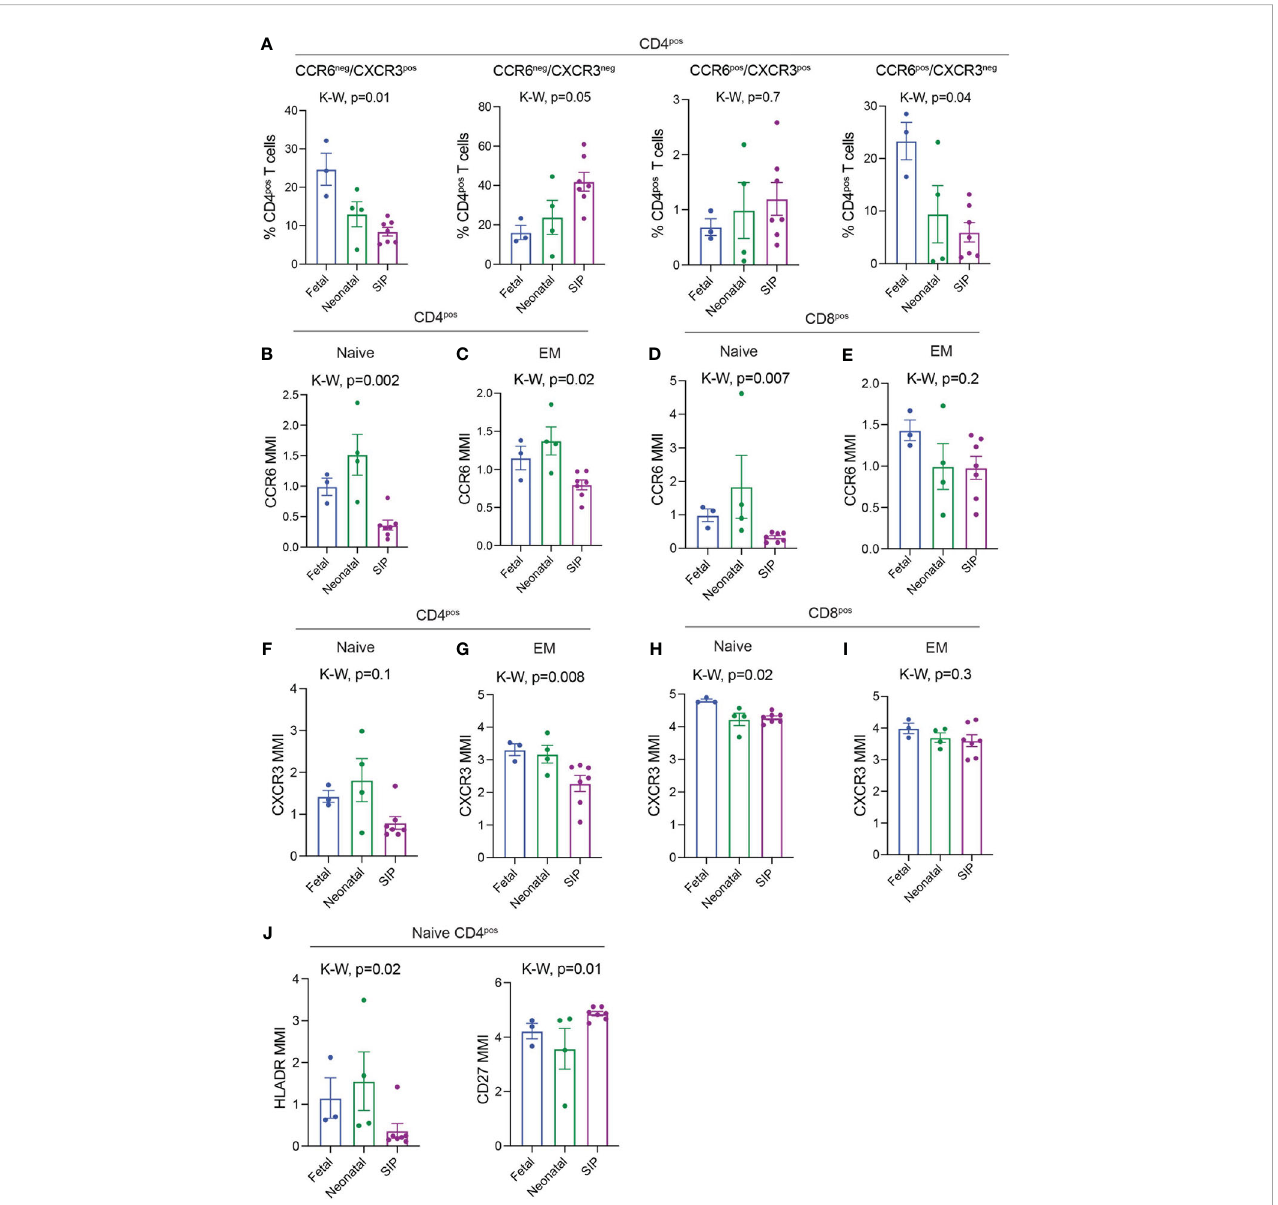
FIGURE 3 CCR6 and CXCR3 expression on T cells in SIP mucosa. (A) CCR6 - CXCR3 + , CCR6 - CXCR3 - , CCR6 + CXCR3 + cells expressed as a percentage of CD4 + T cells. B-E . MMI of CCR6 expression on Naïve CD4 + (B) , EM CD4 + (C) , Naïve CD8 + (D) , EM CD8 + (E) T cells. (F-I). MMI of CXCR3 expression on Naïve CD4 + (F) EM CD4 + (G) , Naïve CD8 + (H) , EM CD8 + (I) T cells. (J) MMI of HLADR and CD27 on Naïve CD4 + T cells. In A, each dot represents 1 case. B – I : Each dot represents the median expression of CCR6 on that population of cells in each case (methods, fetal n=3, neonatal n=4, SIP n=7). EM, effector memory; MMI, mean metal intensity, p-value; K-W, Kruskal-Wallis